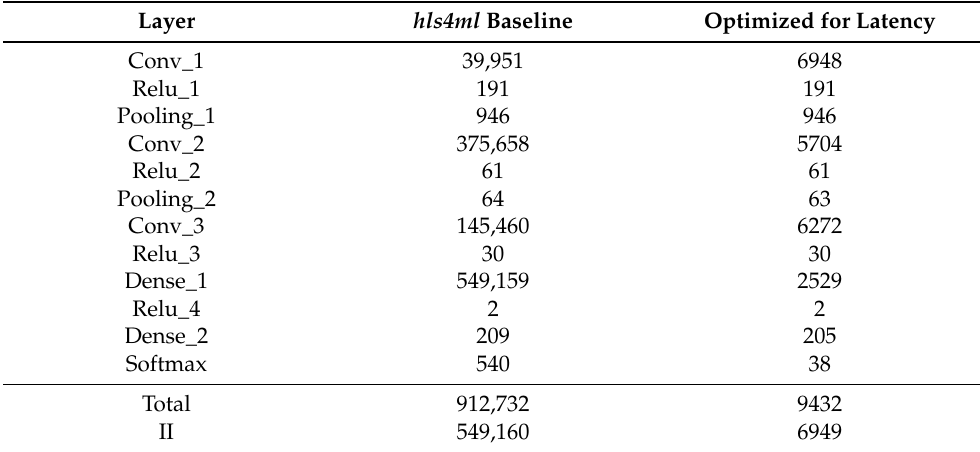
Table 6. Comparison of the latency per layer and II achieved with the hls4ml baseline model and the optimized version for resources and latency (CNN1D). All values are in clock cycles. Layer hls4ml Baseline